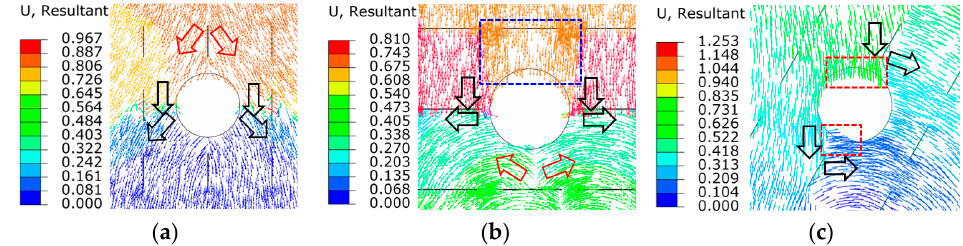
Figure 30. Displacement vector around the hole at the final step in the three typical specimens of different collapse modes (The unit is mm, and the removable blocks are marked by the rectangle areas). ( a ) HC90 (Mode I h ); ( b ) HD0 (Mode II h ); ( c ) HC60 (Mode III h ).